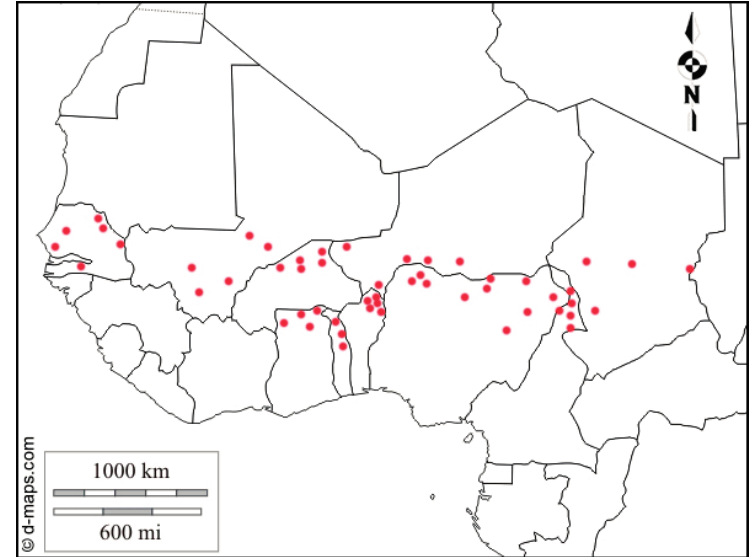
Figure 1. Location of 52 communities sampled. (Base map used with permission from [24]).